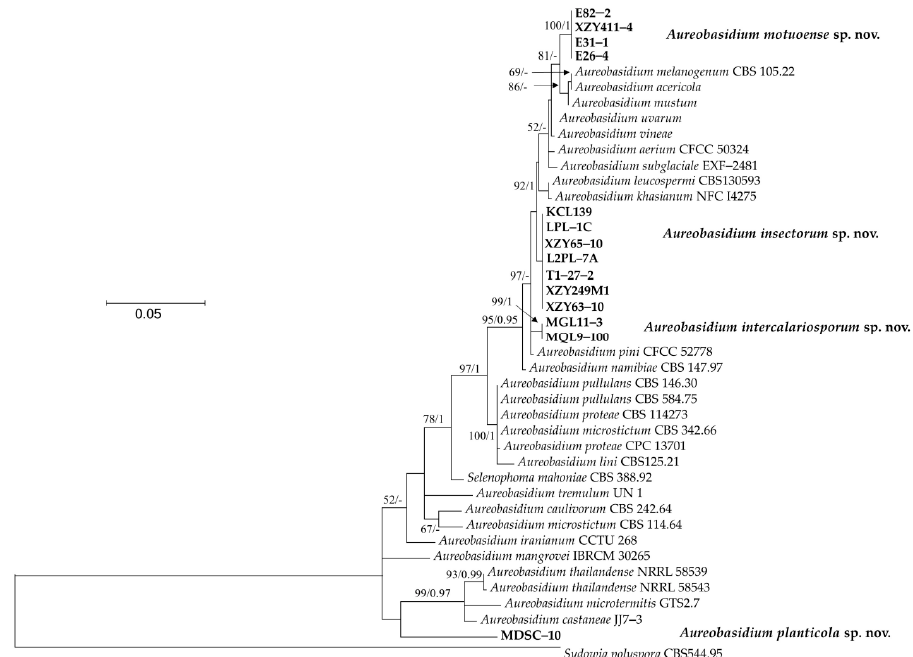
Figure 1. The phylogenetic tree was inferred using the combined sequences of the ITS (including 5.8S rDNA) and LSU rDNA D1/D2 domains, depicting the phylogenetic positions of new taxa (in bold) within Aureobasidium . Bootstrap percentages of maximum likelihood analysis over 50% from 1000 bootstrap replicates and Bayesian inference higher than 0.9 (PP > 0.9) are shown on the deep and major branches. Bar = 0.05 substitutions per nucleotide position. Note: -, not supported (BP < 50% or PP < 0.9). The new taxa isolated in this study are shown in bold.